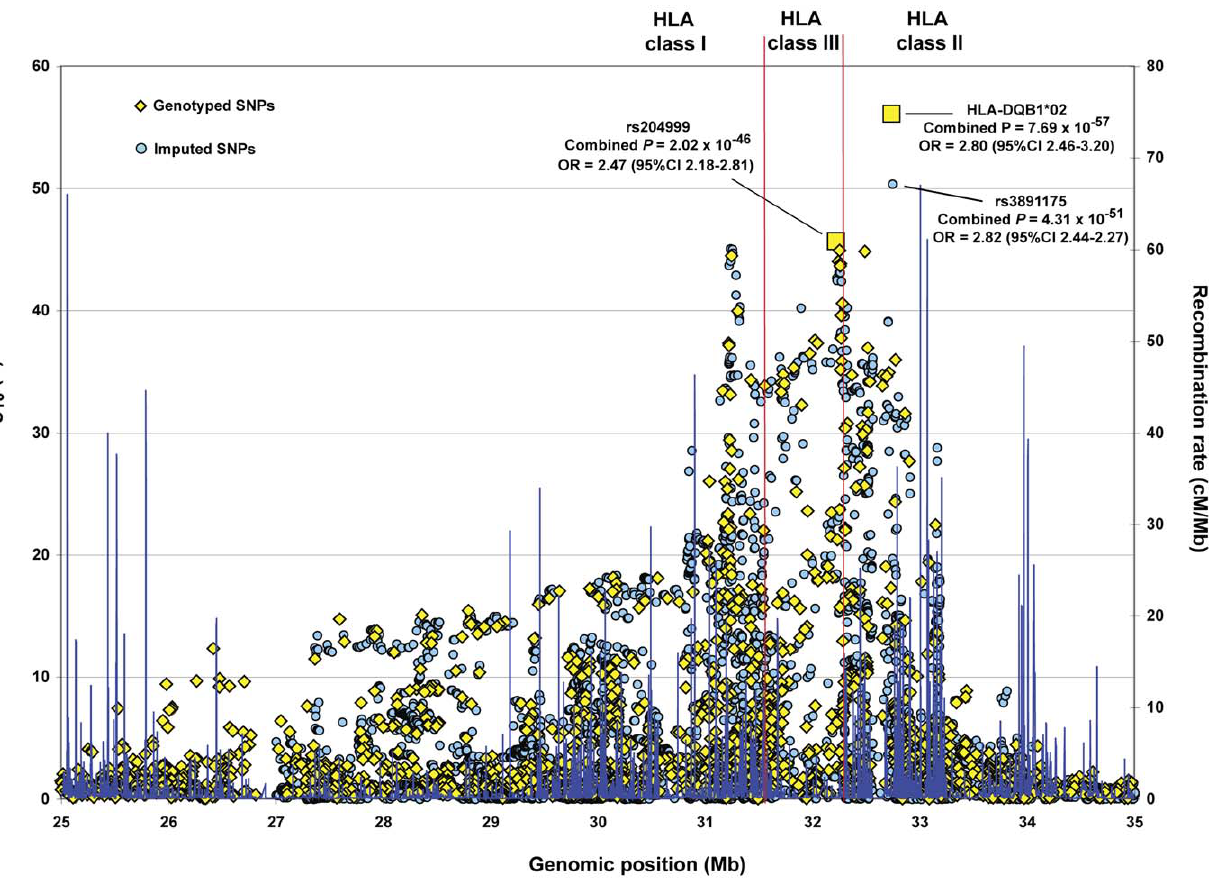
Figure 1. Primary association signal of the HLA locus with IgAD. Allele-based association tests were performed for all 1,686 genotyped SNPs and imputed HLA alleles (represented by yellow diamonds) and for the 9,905 SNPs imputed with high confidence using the HapMap2 reference set (represented by light blue circles). All association results are represented as the 2 log 10 of the combined P values (left y-axis). The most associated SNP and HLA allele are indicated by yellow squares. Recombination rates from the HapMap CEU are depicted in dark blue (right y-axis). Genomic positions on the x-axis are based on the NCBI Build 36 (hg 18) assembly. CI, confidence interval; Mb, megabase pairs.